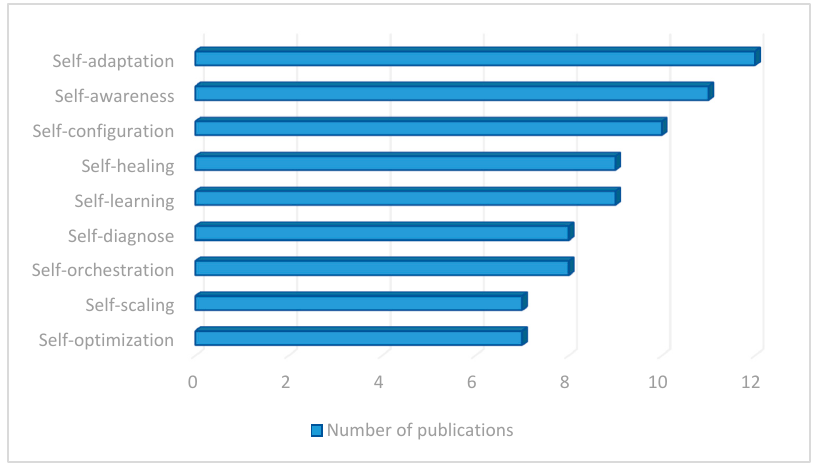
Figure 3. Number of publications by self-* capability.